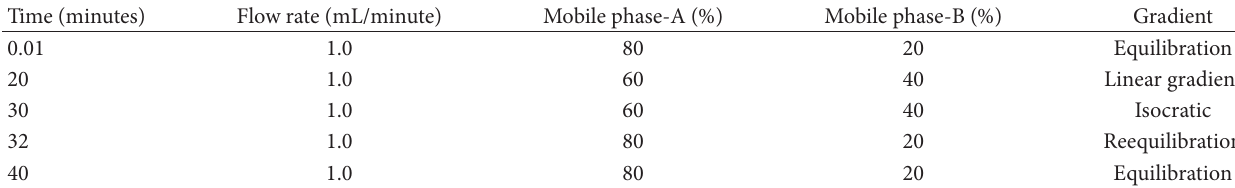
T 1: Gradient programme for related